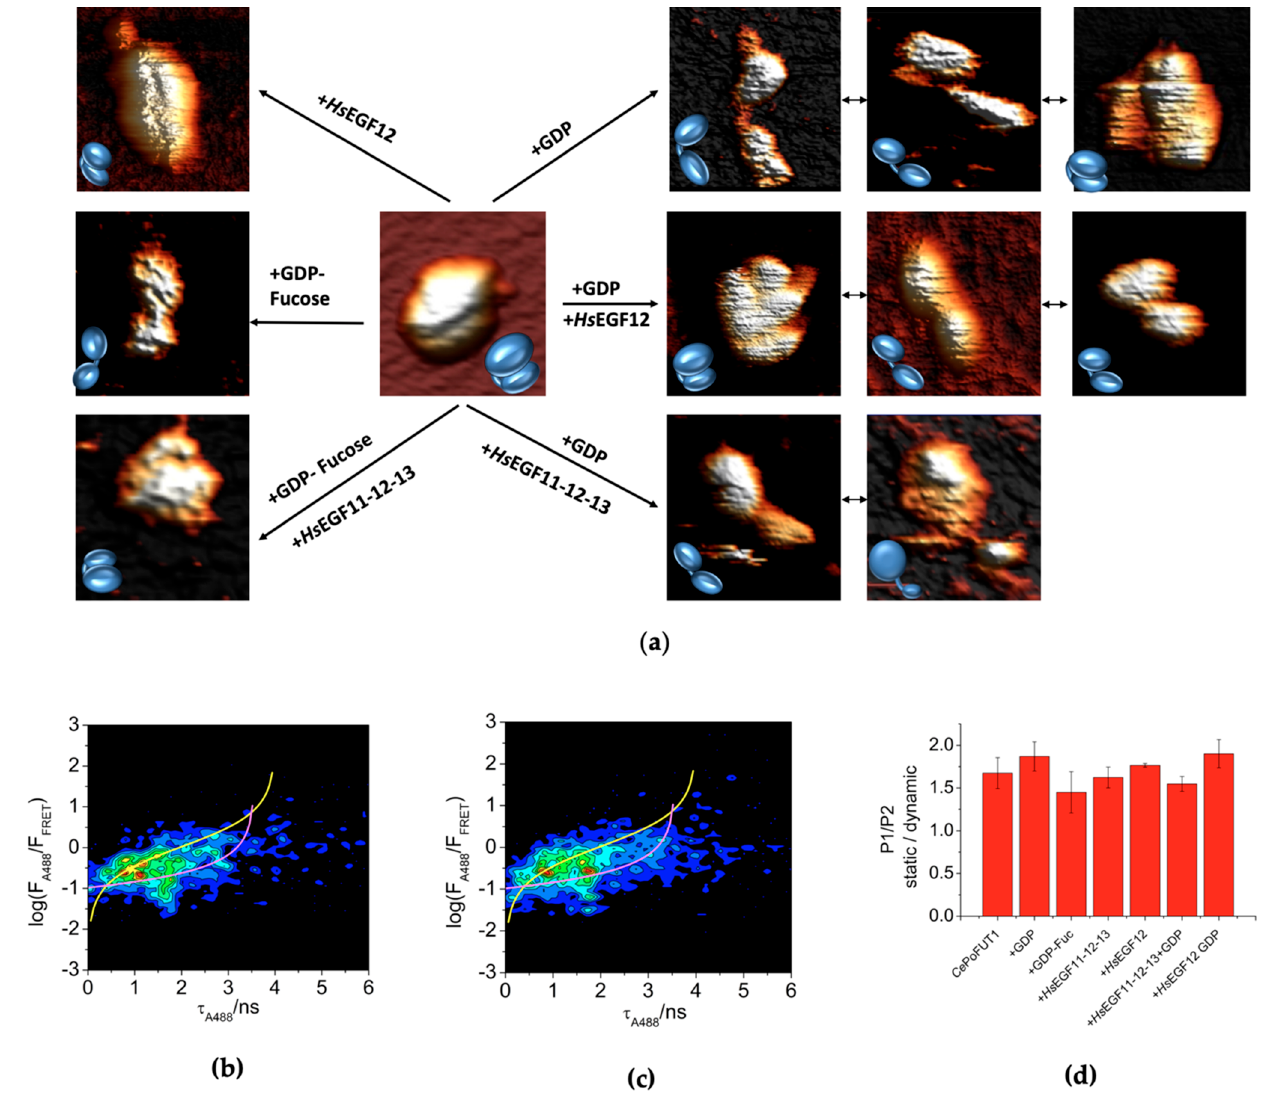
Figure 2. Ce PoFUT1 binding partners. ( a ) Representative AFM topography images taken in HEPES, pH 7.0 showing the main species found: highly-compact structure Ce PoFUT1 (center panel); transition from highly extended structure to compact structure in the presence of GDP (upper right panel); transition from compact structure to close extended in presence of GDP and Hs EGF12 (middle right panel); extended structure in presence of GDP and Hs EGF11-12-13 (bottom right panel); very compact structure in presence of GDP-Fuc and Hs EGF11-12-13 (bottom left panel); extended structure in presence of GDP-Fuc (middle left panel); and very compact structure in presence of Hs EGF12 (upper left panel). Images present a high-level contrast to show better the domains. The features appear next to outlined ball shapes that represent the species found. ( b and c ) Representative SMF-FRET correlograms (log( F A488 / F FRET ) vs. τ A488 ) of Ce PoFUT1 in the presence of GDP-Fuc ( b ) and GDP ( c ). ( d ) Ratio of the static and dynamic populations (P1/P2) of Ce PoFUT1 in the presence of different substrates/products.